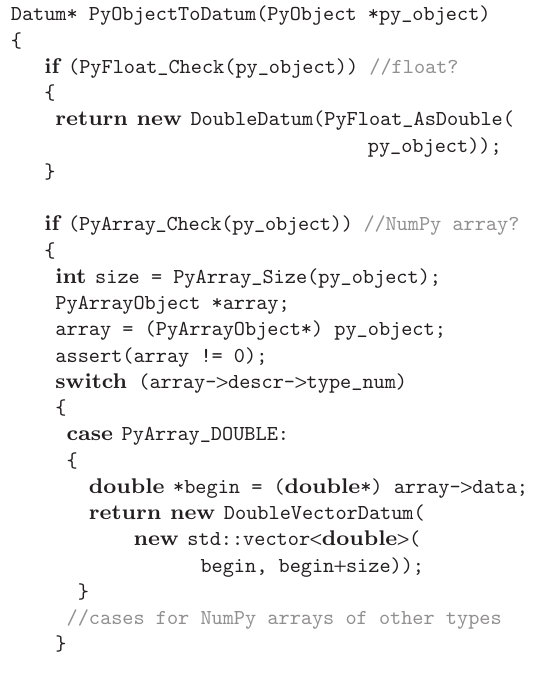
FIGURE 2 | Sequence diagram showing the interaction between Python and SLI. A call to the PyNEST high-level function Create() fi rst transmits the model name to SLI using sli_run() . It is converted to the SLI type literal by the interpreter ( (cid:99) ). Next, it pushes the number of nodes (10) to SLI using sli_push() . The PyNEST low-level API converts the argument to a SLI datum ( (cid:100) ) and pushes it onto SLI’s operand stack. Next, it